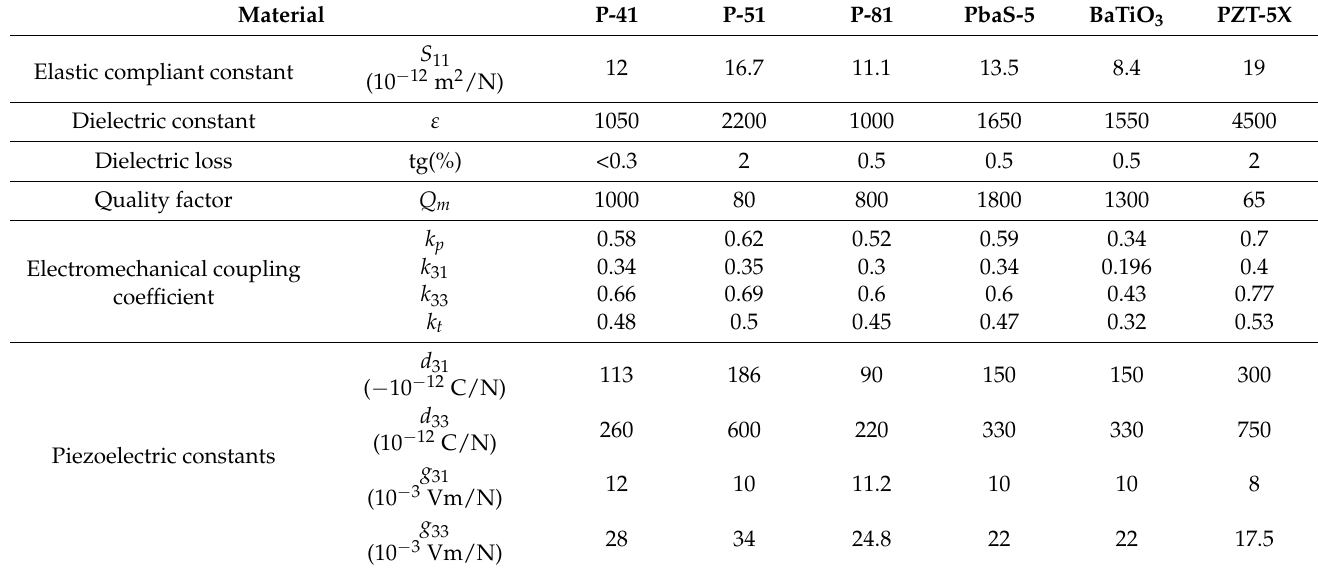
Table 2. Performance parameters of piezoelectric